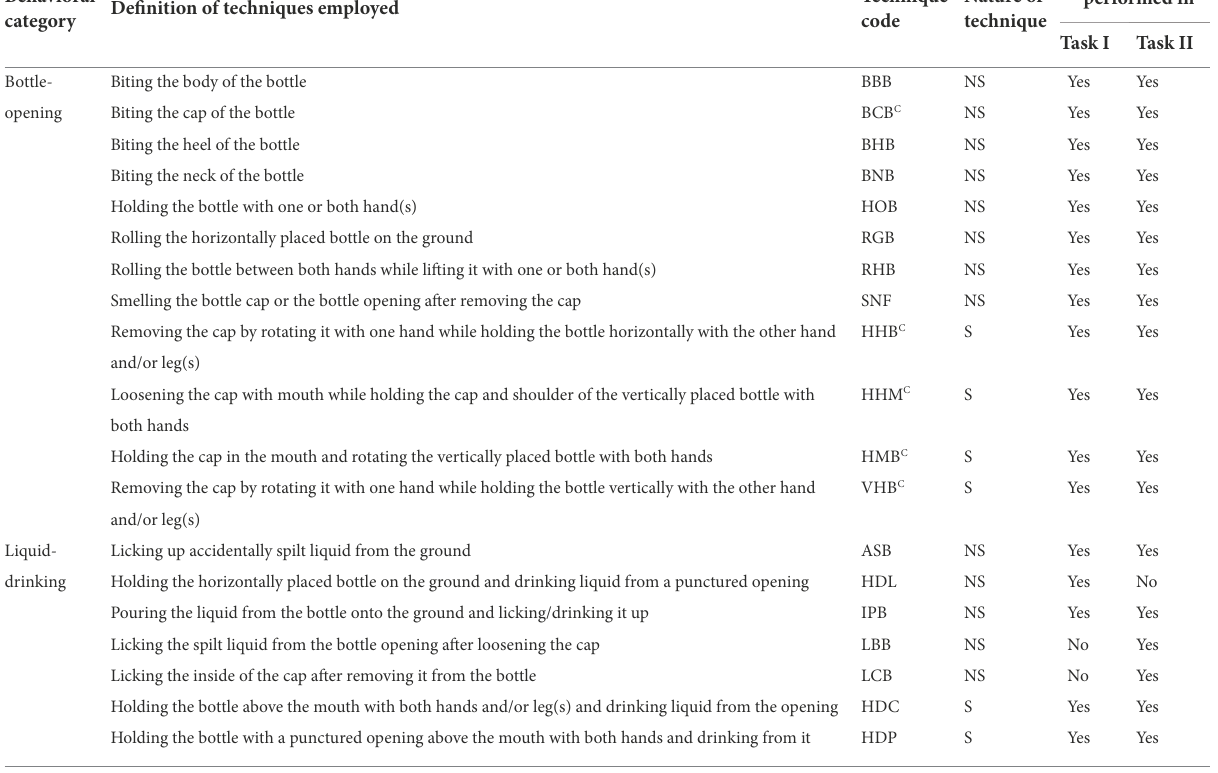
Behavioral Definition of techniques category